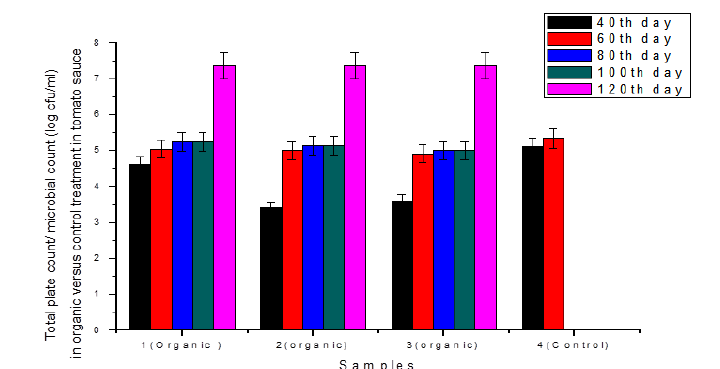
Fig. 2. Total plate count (log cfu/ml) of ketchup produced from organically and conventionally grown